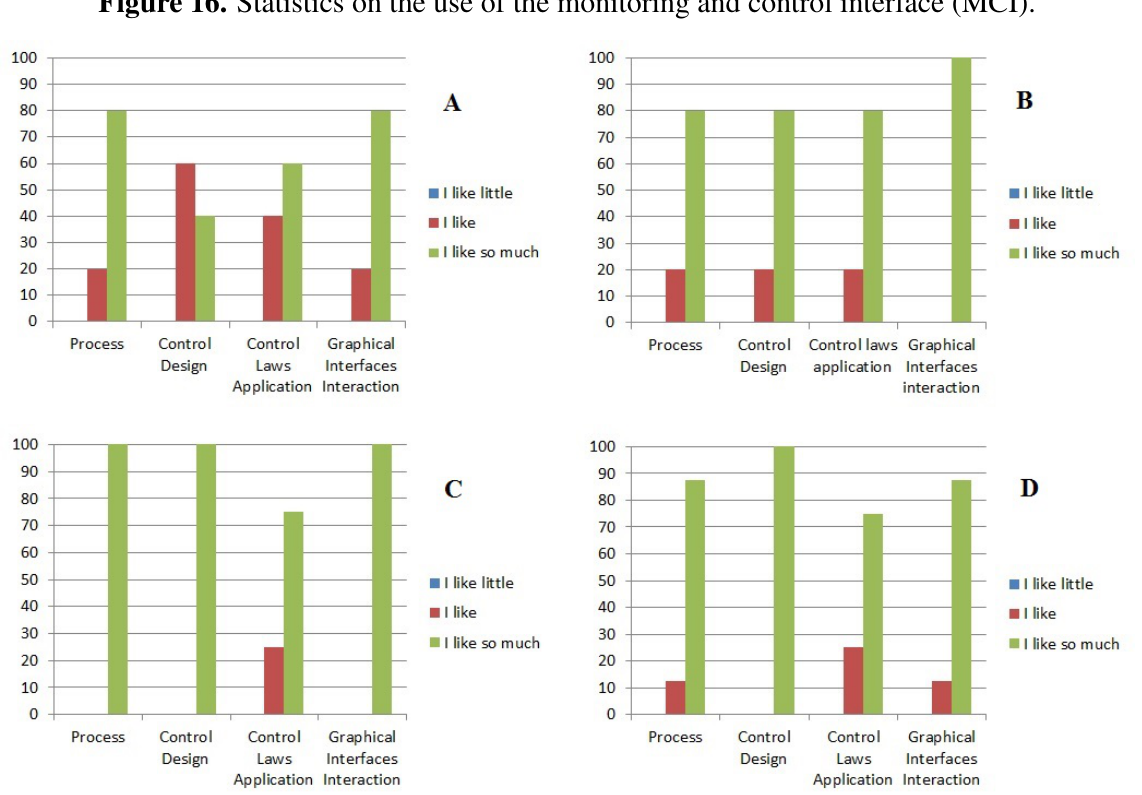
Figure 16. Statistics on the use of the monitoring and control interface